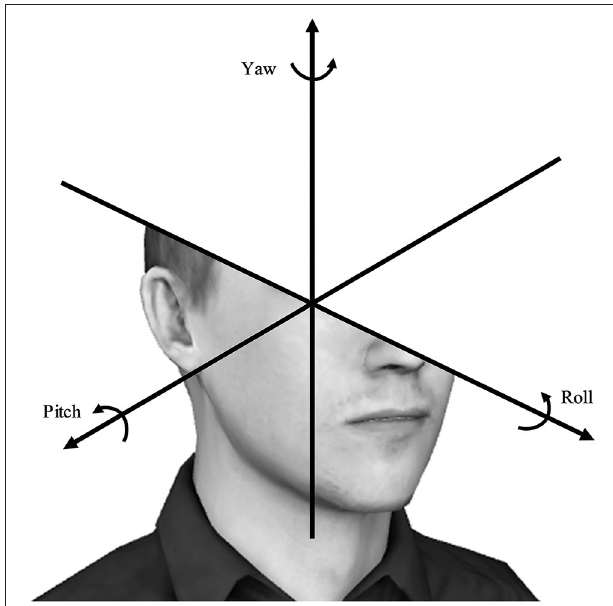
FIGURE 2 | Depiction of the three angles of rotational movement- pitch, yaw, and roll.